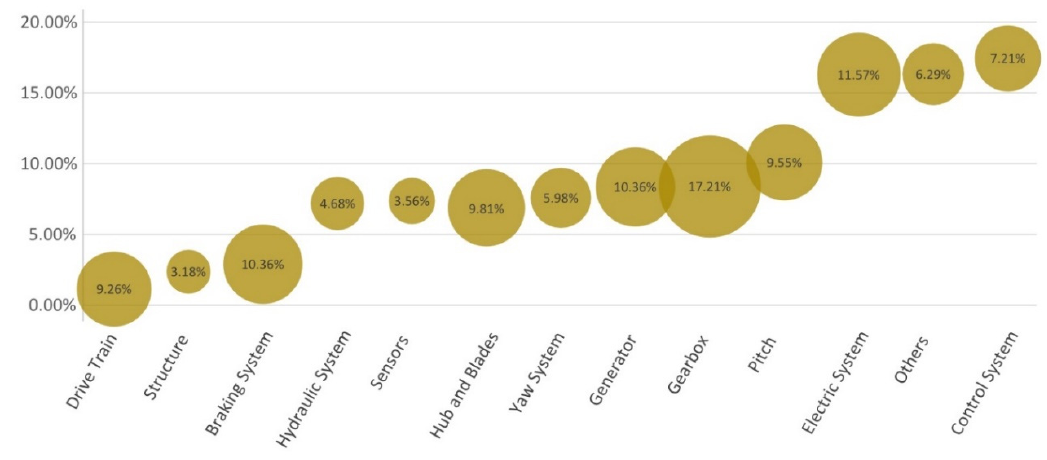
Figure 2. Average wind turbine (WT) component failure rate (Y-axis) and downtime (bubble size) based on previously published studies compiled in [19].